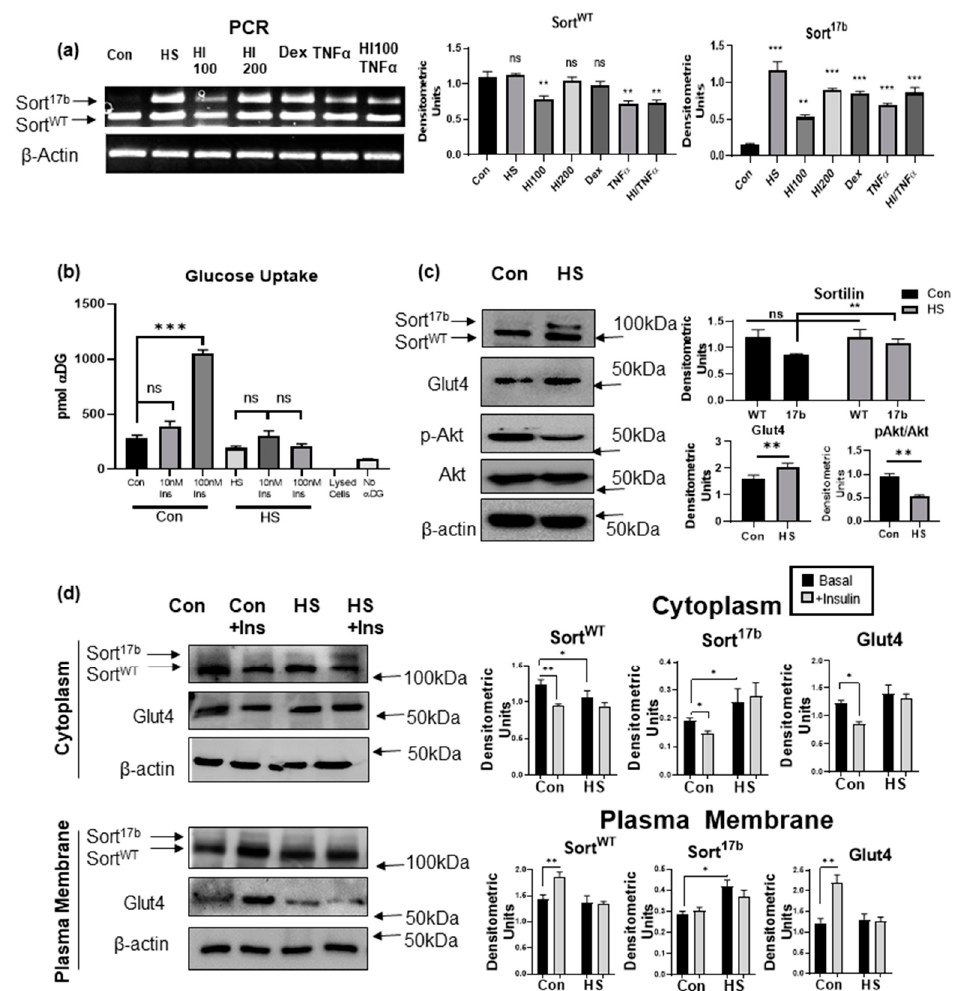
Figure 3. Insulin resistance induced in 3T3L1 adipocytes results in increased Sort 17b . ( a ) 3T3L1 pre-adipocytes (day 0) were differentiated (as described in methods) for 2 days. Insulin resistance methods were then induced (10% high serum